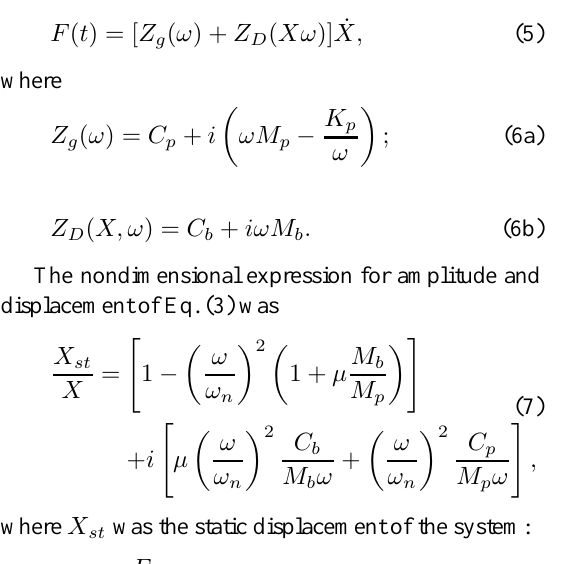
Fig. 1. Schematic diagram of bean bag vibroimpact